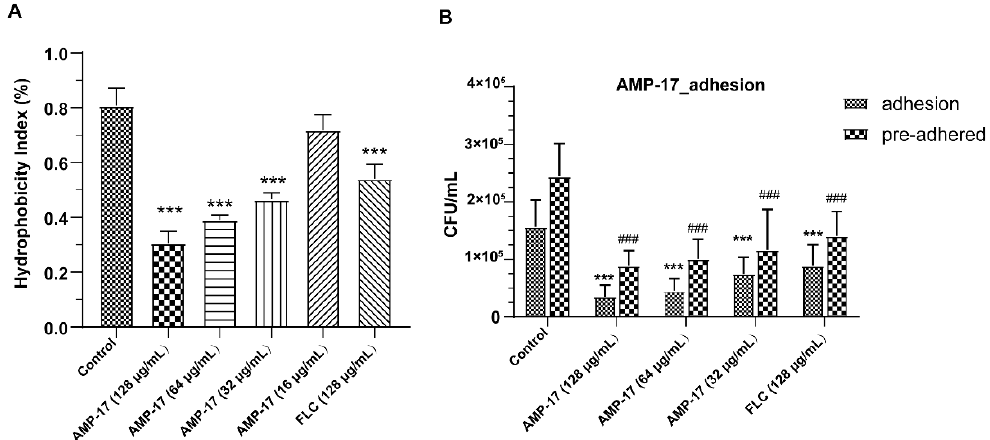
Figure 4. The effect of AMP-17 on the hydrophobicity and adhesion of C. albicans . ( A ) Hydrophobicity index (%) of C. albicans SC5314 after exposure to various AMP-17 concentrations. ( B ) The number of C. albicans cells that adhered on a 24-well polyethylene plate after 90 min of exposure to AMP-17. Experiments were repeated three times on three separate occasions and the results are displayed as the mean of each individual experiment, with the calculated standard deviation shown as error bars. *** p < 0.001 or ### p < 0.001 were obtained for control versus corresponding treated samples.